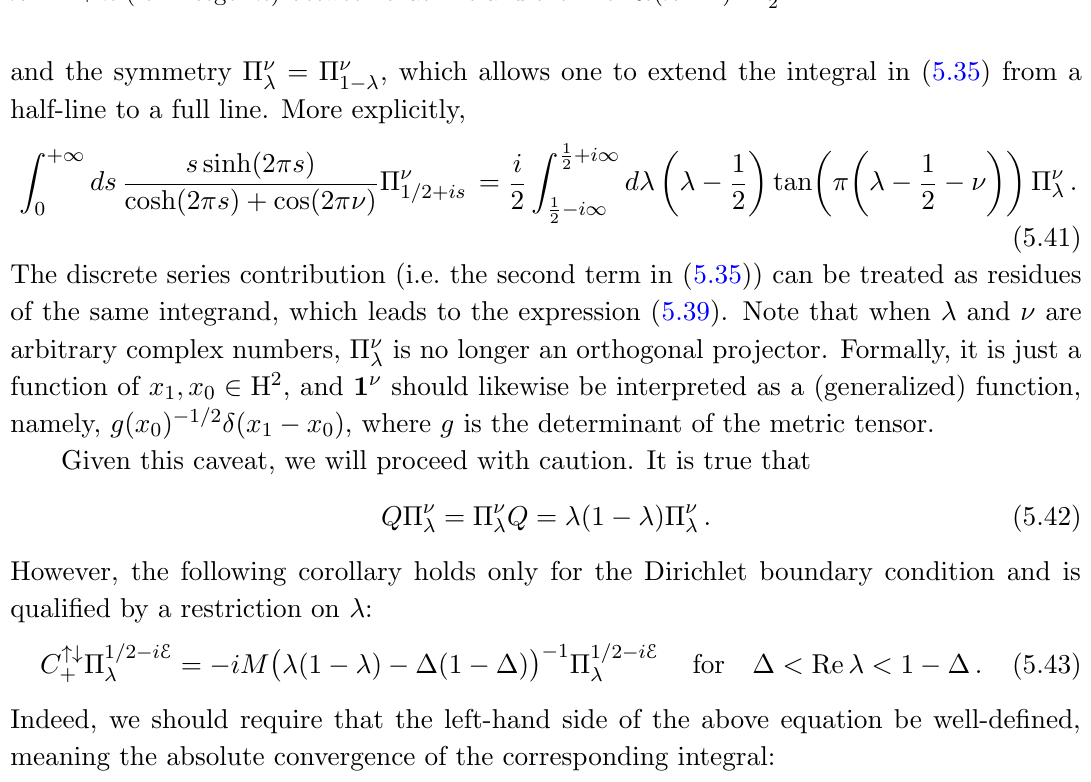
Figure 9. Contour (cid:0) in eq. (5.39) includes the vertical line Re (cid:21) = 1 (cid:21) = (cid:23) + n (for integer n ) between that line and the line Re( (cid:21) (cid:0) (cid:23) ) = 1